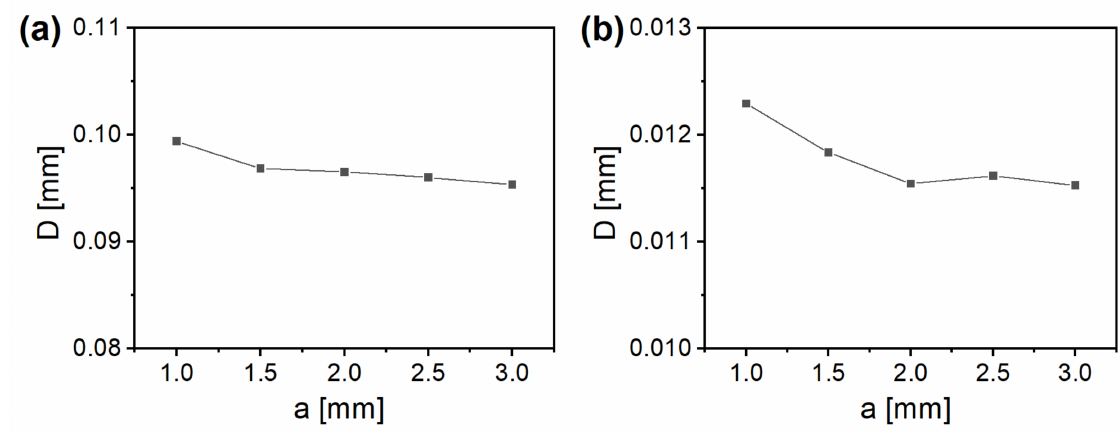
Figure 10. Electron beam size as a function of Einzel lens size: ( a ) at the anode; ( b ) at the membrane.